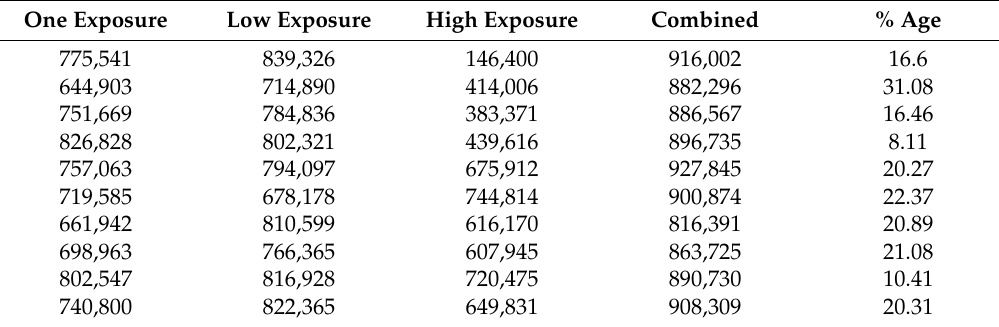
Table 3. Several 3D points for multi-capture with a single